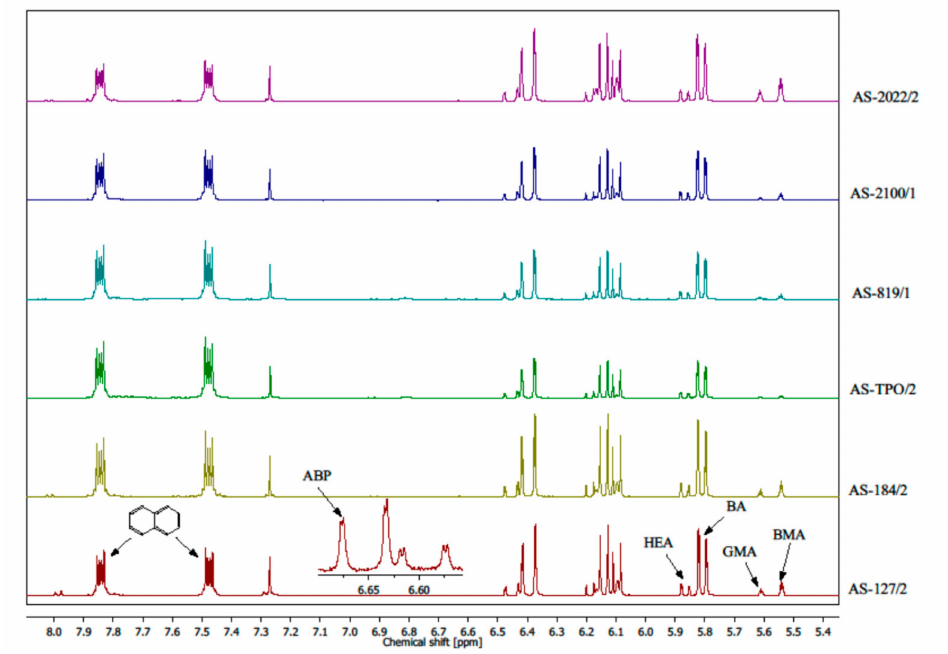
Figure 3. Stacked plot of the proton nuclear magnetic resonance ( 1 H NMR) spectra of acrylic syrups. Peaks monitored for each monomer and the internal standard (naphthalene) are indicated.